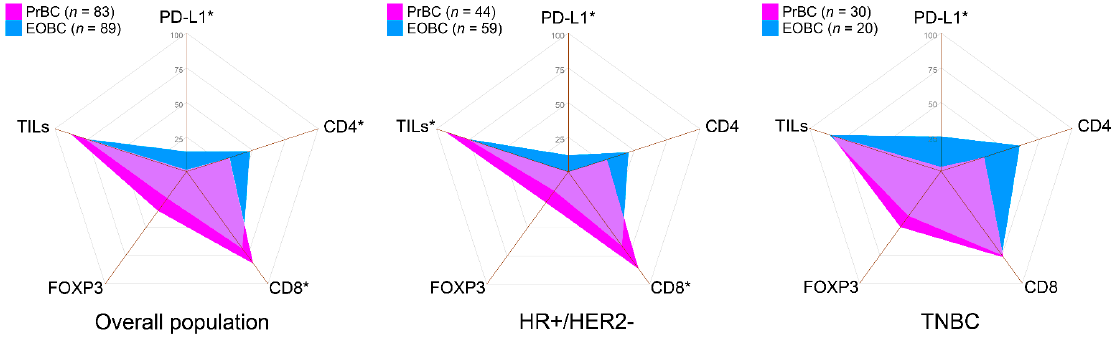
Figure 3. Immunograms showing the prevalence of patients with selected immune-related features in the study and control groups, according to the subtype. PrBC, breast cancer during pregnancy;